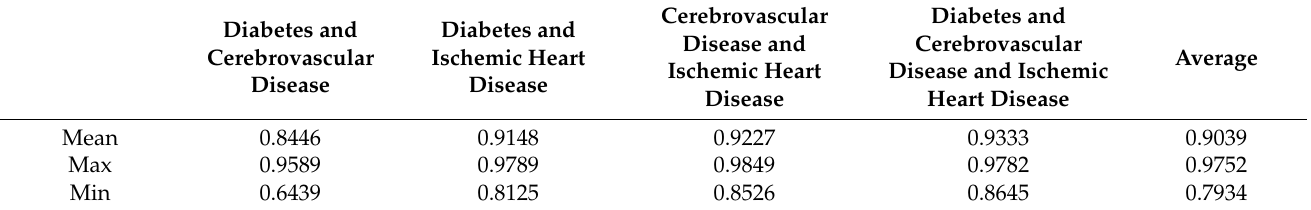
Table 5. Joint learning